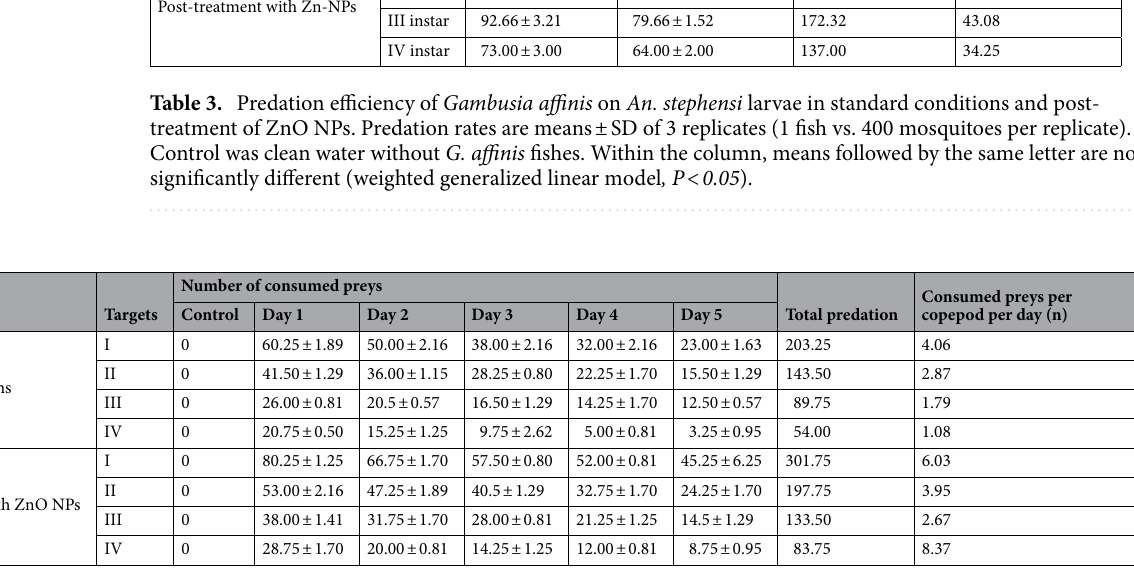
Table 4. Predation efficiency of Mesocyclops aspericornis on An. stephensi larvae in standard conditions and post-treatment of ZnO NPs. Predation rates are means ± SD of four replicates (1 G. affinis fish vs. 100 mosquitoes per replication). No predation in control (i.e. clean water without G. affinis fish). Within each column, means followed by the same letter are not significantly different (P < 0.05).